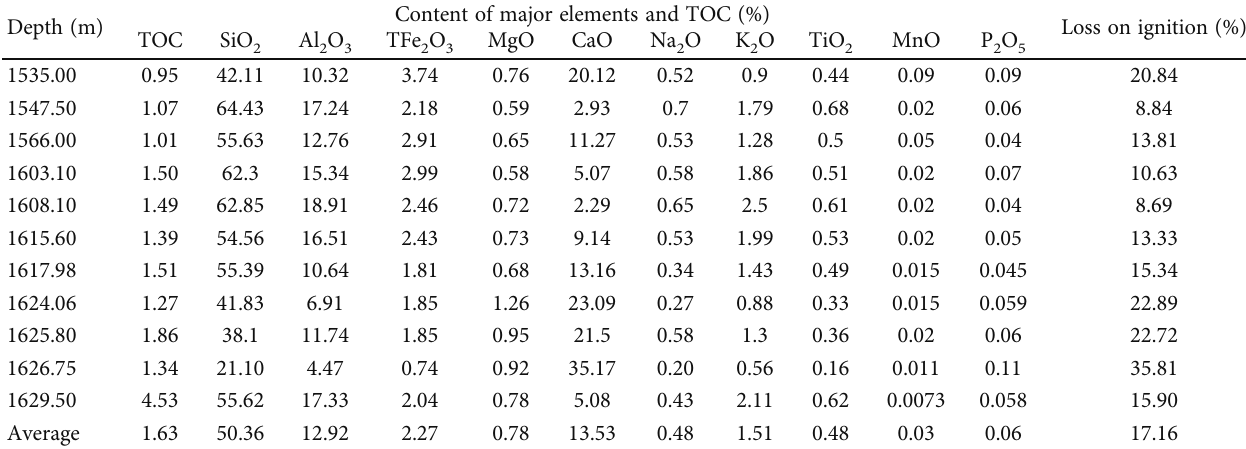
Table 1: Results of trace elements of Lower Carboniferous black shale in Rongshui, Guangxi.